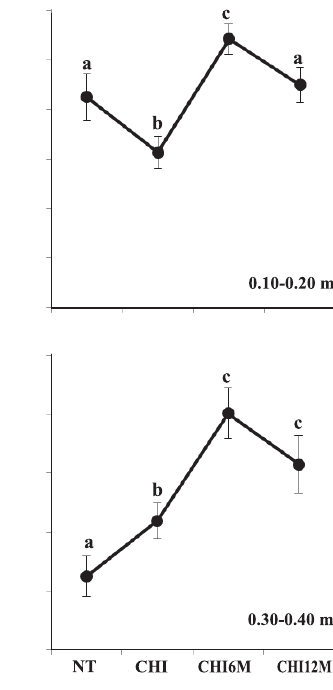
figure 5. mean values and respective confidence intervals for the degree of compaction in the different sampling periods. nT: no-tillage before chiseling; chi: immediately after chiseling; chi6m: six months after chiseling; chi12m: 12 months after chiseling. same letters indicate overlap of the confidence